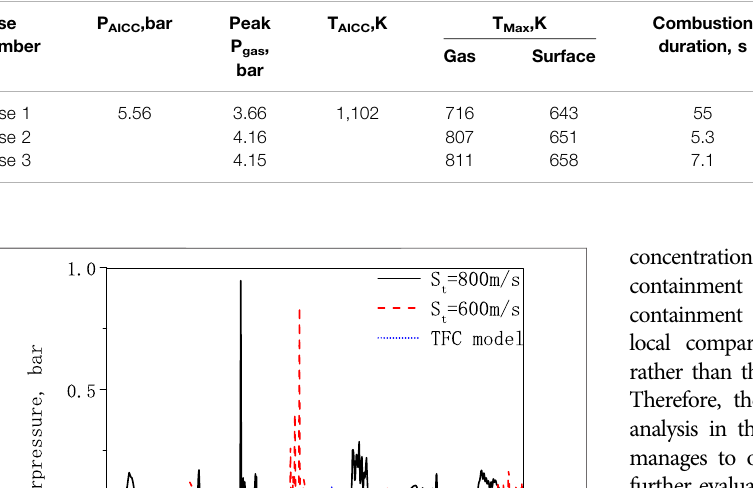
TABLE 4 | Summary of global combustion characteristics.